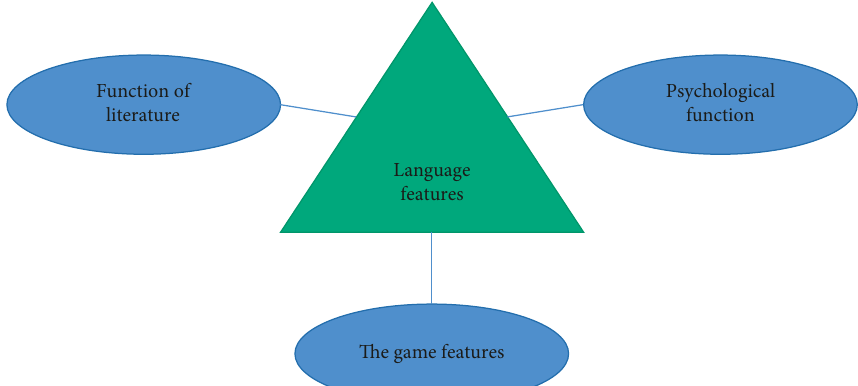
Figure 10: Three main categories of language